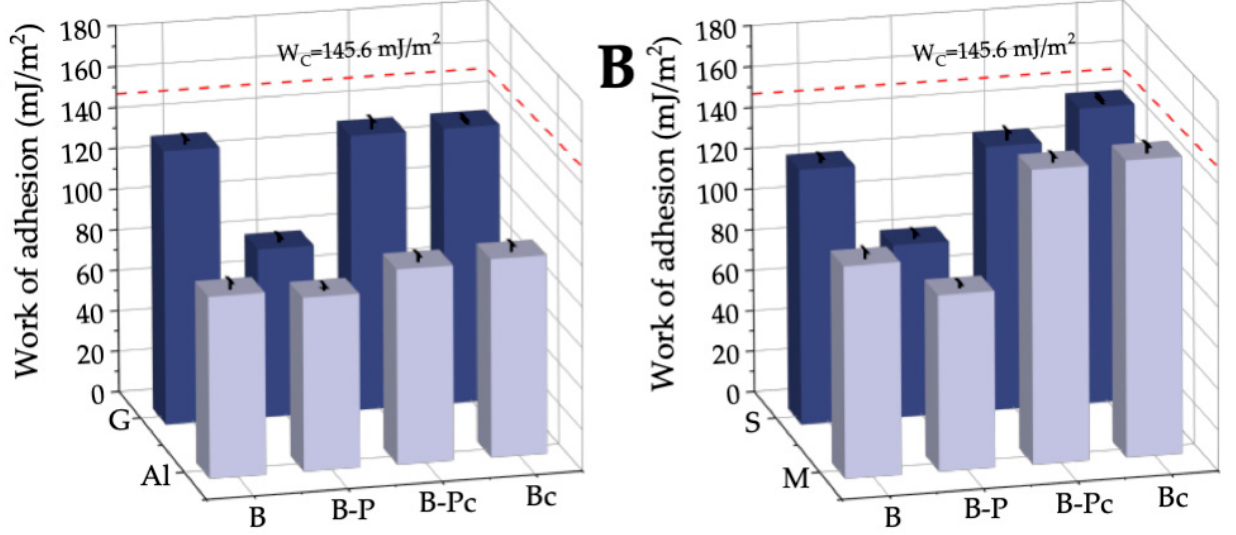
Figure 8. Work of adhesion of water to the bare sensitive surface samples, covered with paint (B-P), after paint removal (B-Pc), and cleaning bare surfaces with NE No. 10 (Bc). ( A ) The surfaces produced from man-made materials. ( B ) The surfaces produced from natural materials.